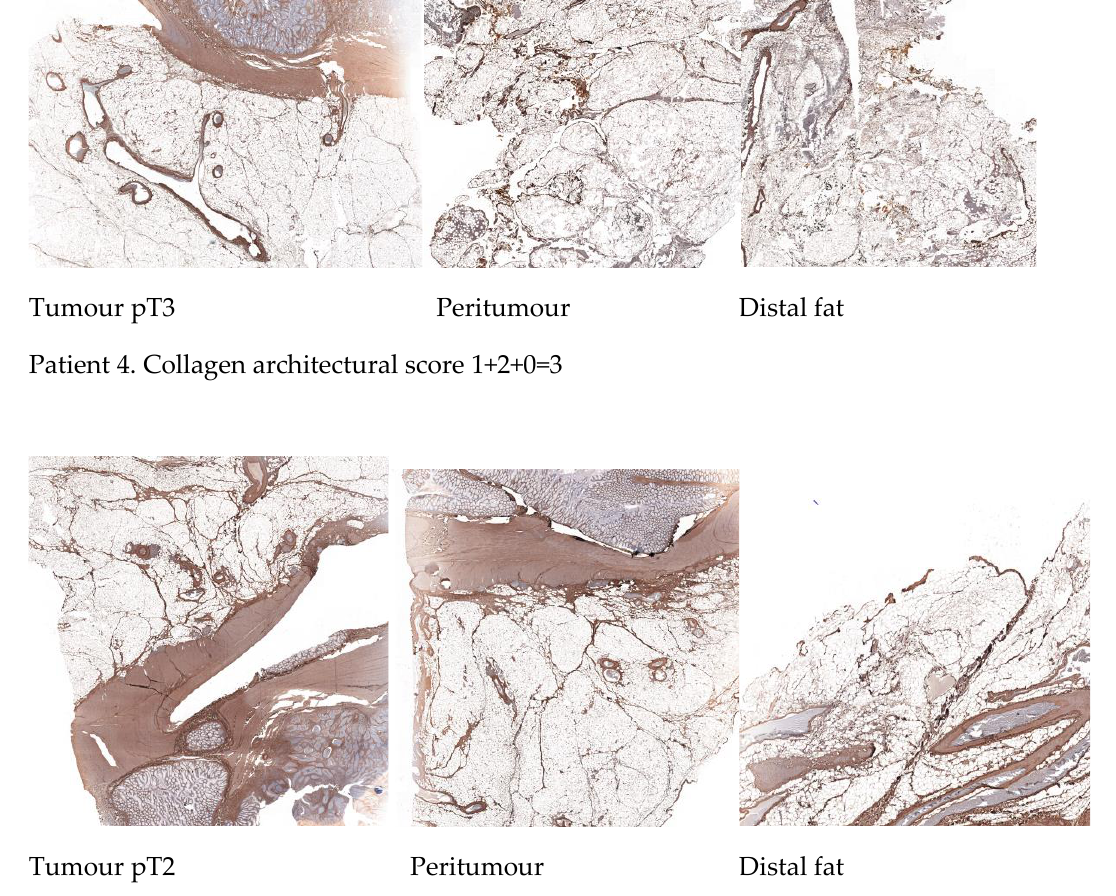
Figure 6. Immunohistochemical staining for COL1A1 expression in colon cancer tissue, peritumour adipose tissue and distal adipose tissue in 5 colon cancer patients. A “mesenteric collagen architectural score” based on collagen bundles and architecture of adipose tissue lobes is reported for each patient. We hypothesize COL1A1 up-regulation is mediated by down regulation of Wingless/Integrated (Wnt) pathway, contributing to the creation of a propagating mesenteric collagen network to reach target organs and facilitate engraftment and colonisation.